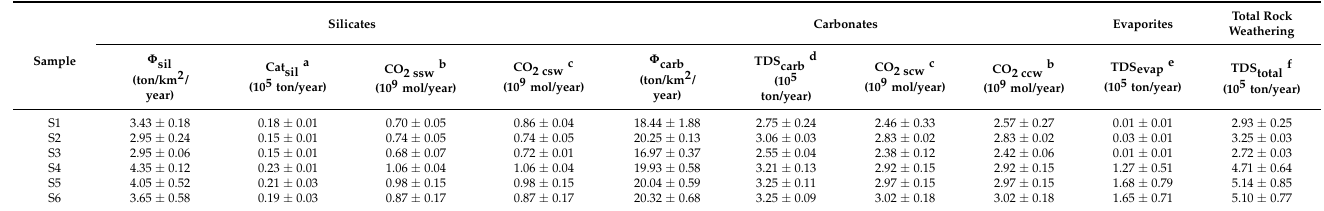
Table 4. Chemical weathering rate and CO 2 consumption of small